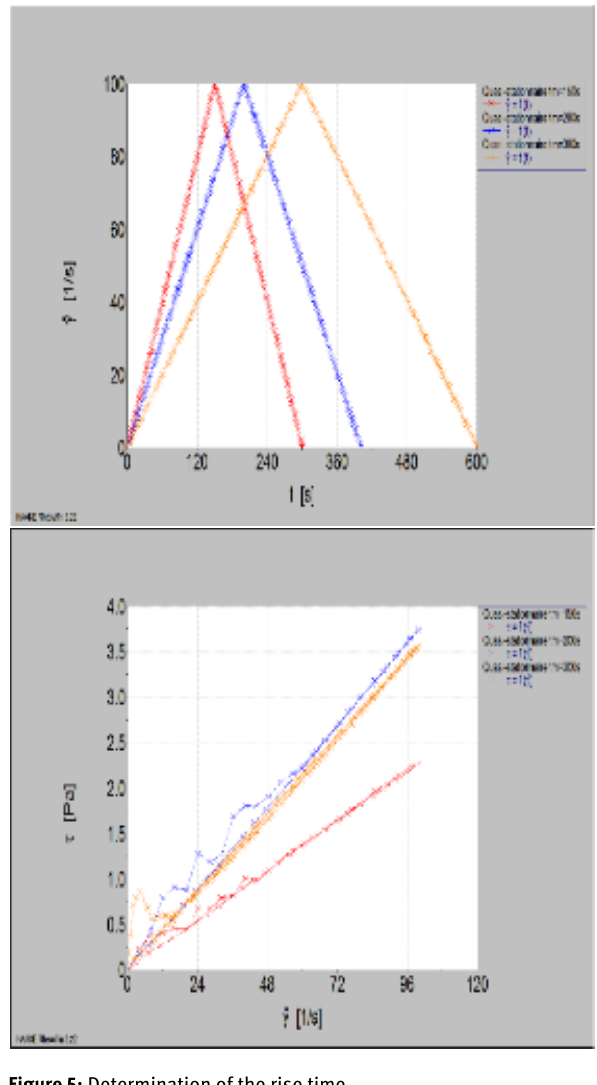
Figure 5: Determination of the rise time